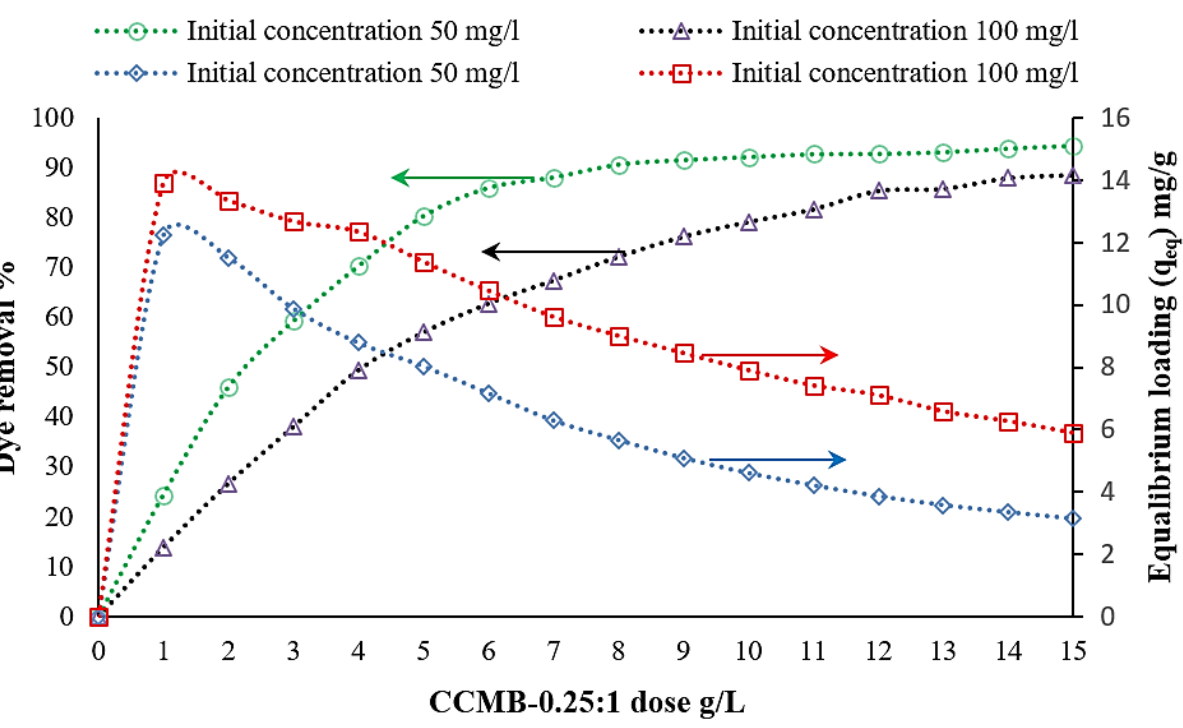
Figure 12. Effect of CCMB-0.25:1 concentration on DB78 dye removal efficiency (temperature of 22 °C, pH of 3.5, mixing speed of 150 r.p.m., and contact time of 120 min). Table 2. Optimal adsorbent concentrations for direct blue 78 dye removal.